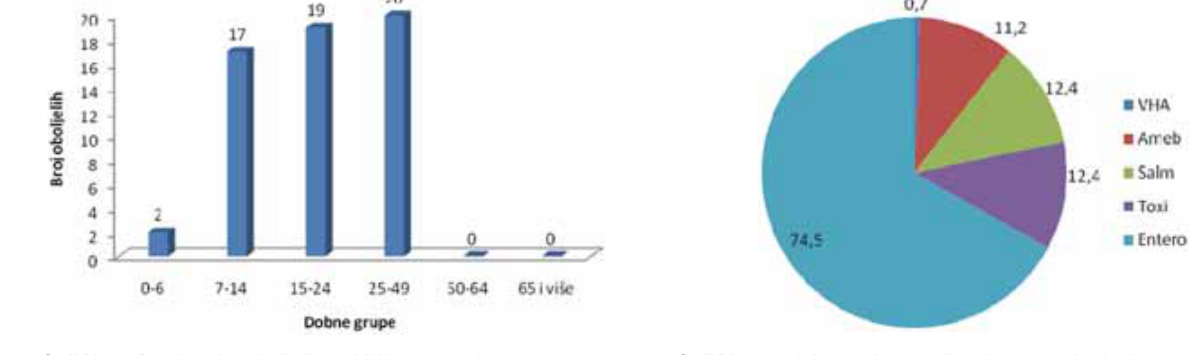
SLIKA 6. Indeks strukture crijevnih zaraznih oboljenja